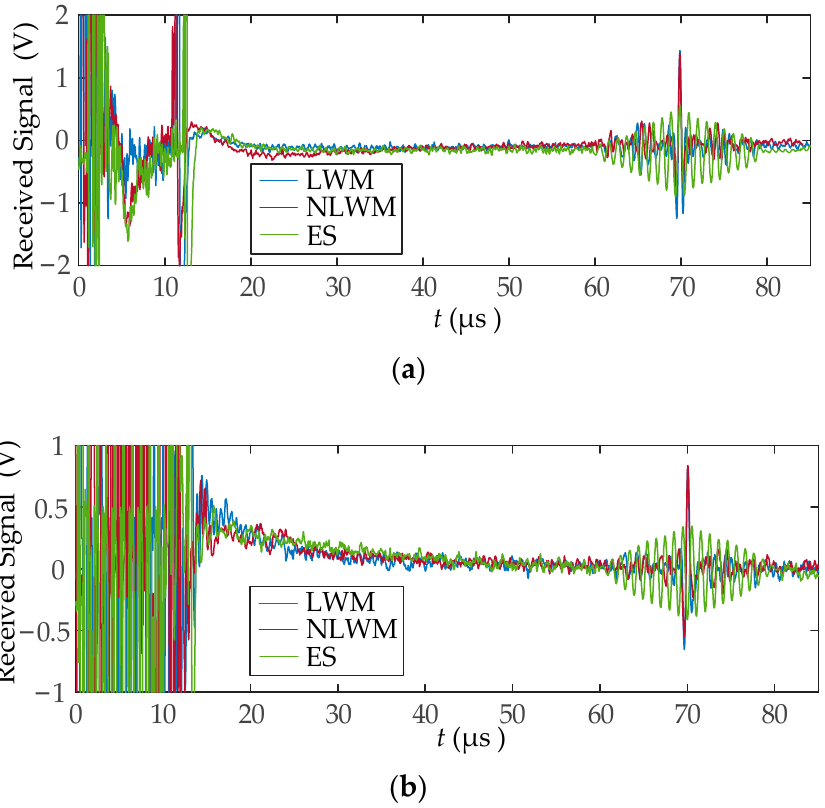
Figure 13. The received signals after the ultrasonic receiver: ( a ) case 1; ( b ) case 2.